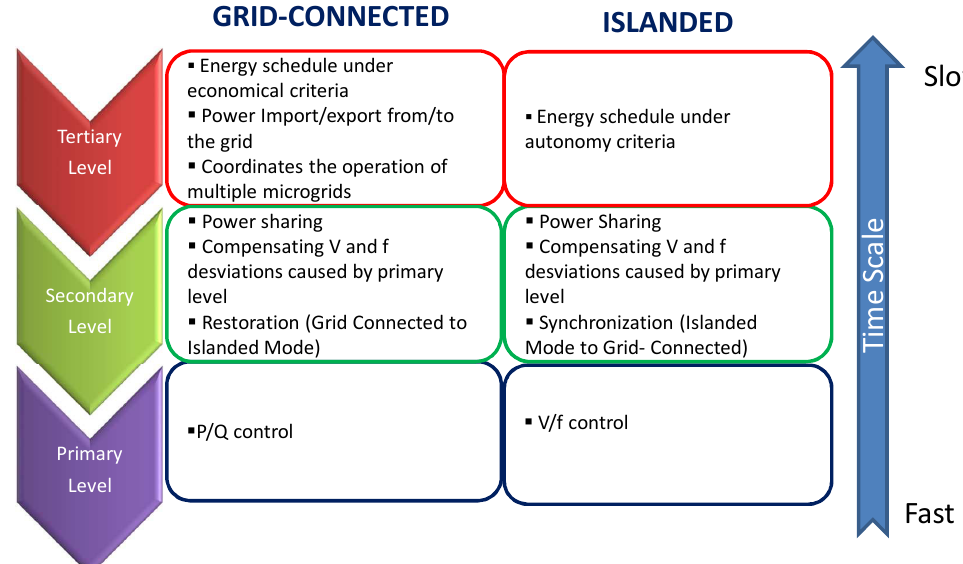
Figure 3. Microgrid control levels and operation